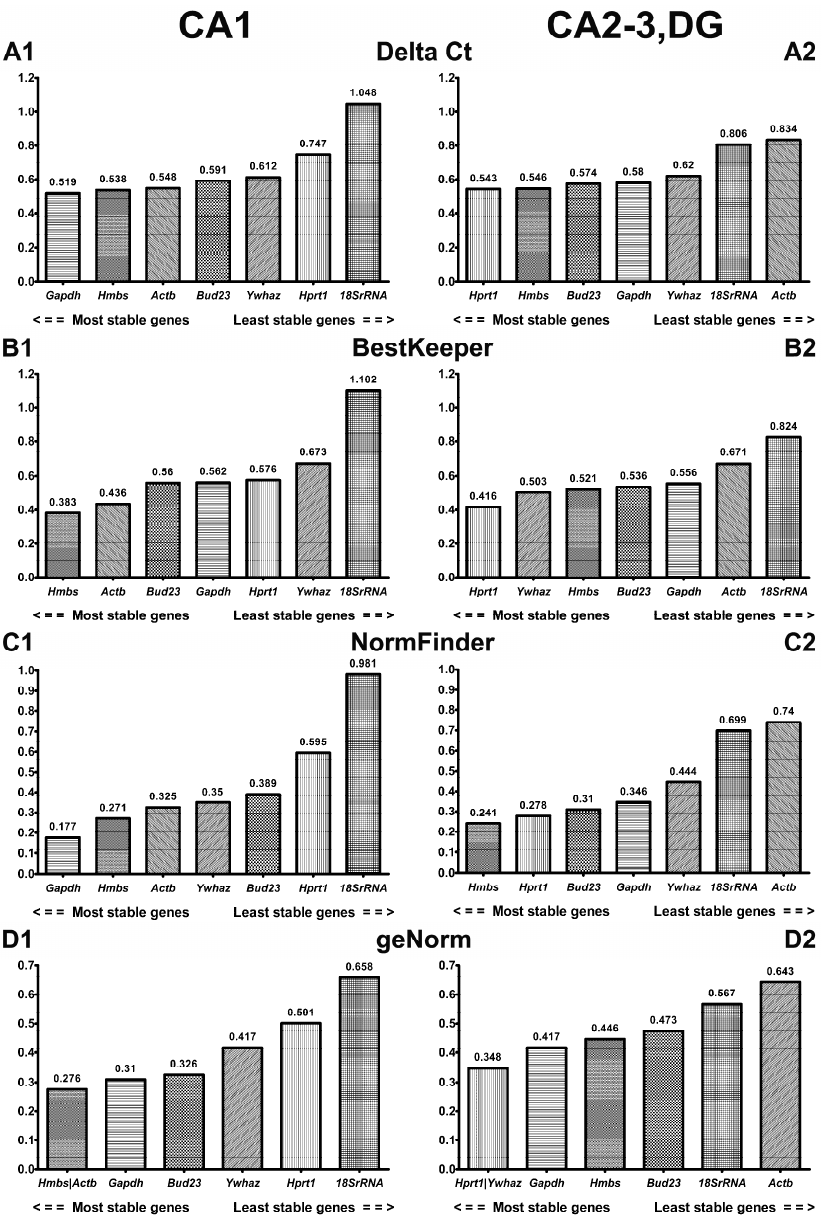
Figure 3. Stability rankings of seven candidate reference genes in CA1 and CA2-3,DG parts of gerbil hippocampus, calculated separately by four algorithms: ∆ Ct, BestKeeper, NormFinder, and geNorm. Data are presented from the most stable (left) to the least stable gene. n = 15. ( A1 ). ∆ Ct in CA1; ( A2 ). ∆ Ct in CA2-3,DG; ( B1 ). BestKeeper in CA1; ( B2 ). BestKeeper in CA2-3,DG; ( C1 ) . NormFinder in CA1; ( C2 ). NormFinder in CA2-3,DG; ( D1 ). geNorm in CA1; ( D2 ). geNorm in CA2-3,DG.